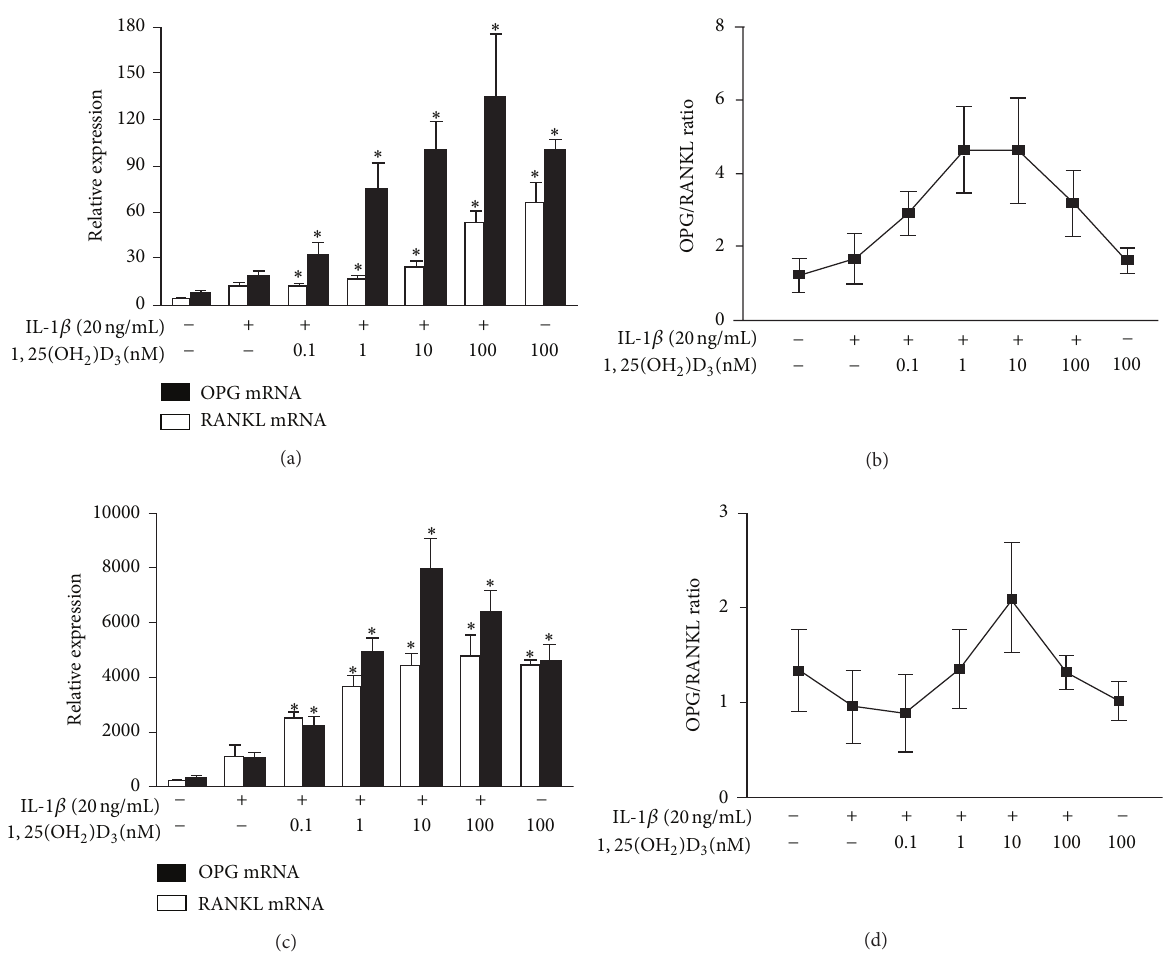
Figure 2: Effect of 1,25(OH) 2 D 3 on IL 𝛽 -induced RANKL and OPG expression in MH7A and primary RA fibroblast-like synoviocyte. MH7A cells were stimulated with 20ng/mL IL1 𝛽 and then treated with different concentrations of 1,25(OH) 2 D 3 (0.1nM, 1nM, 10nM, and 100nM) for 48h. The effect of 1,25(OH) 2 D 3 on RANKL and OPG expression in IL1 𝛽 -induced MH7A (a) and RA-FLS (c) was analyzed by real-time PCR. The alteration of OPG/RANKL ratio in IL1 𝛽 -induced MH7A (b) and RA-FLS (d) was analyzed (b). The data points shown are the mean ± SD for three independent experiments, each in triplicate. ∗ 𝑃 < 0.05 compared to cells cultured with IL-1 𝛽